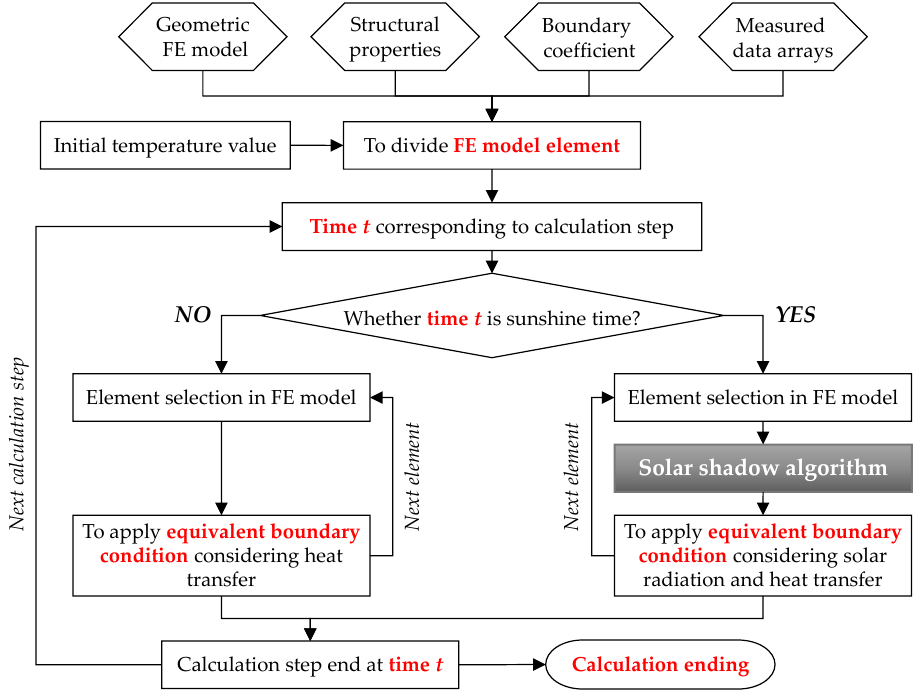
Figure 6. Framework of the numerical simulation considering solar radiation effects.